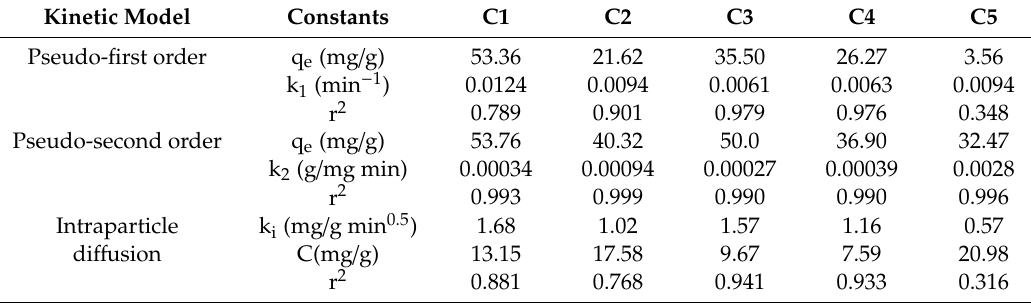
Table 5. List of estimated parameters from Lagergren pseudo-first-order, pseudo-second-order and intraparticle di ff usion kinetic models; r 2 is the regression coe ffi